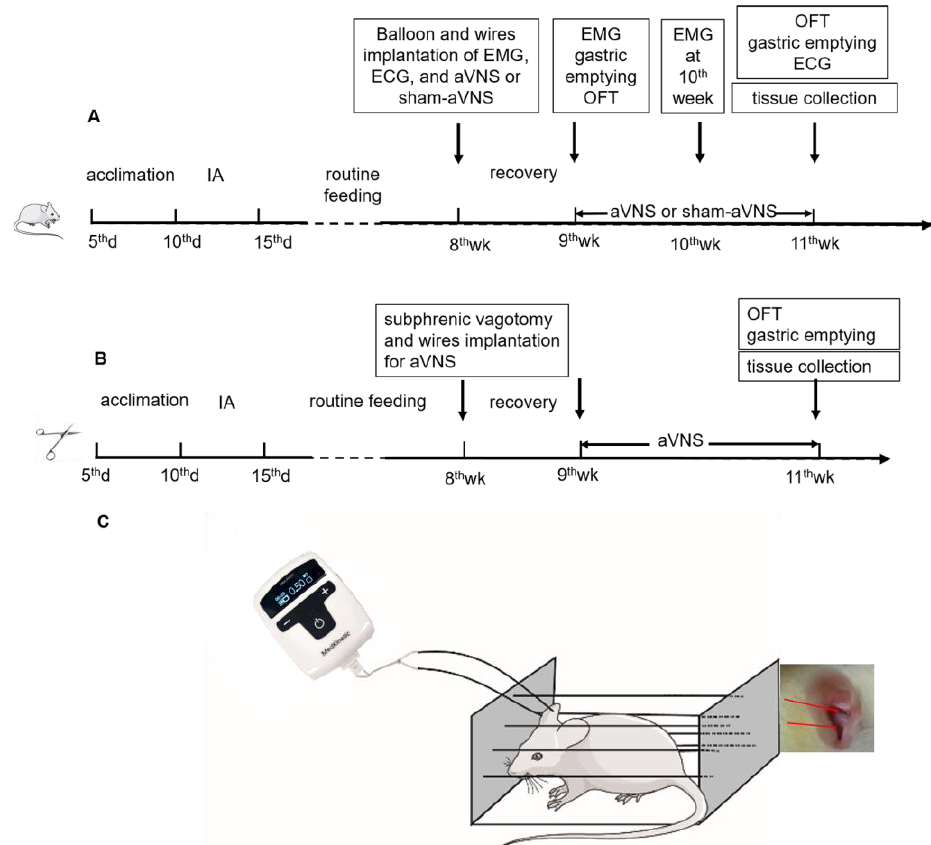
Figure 1. ( A ) Flowchart of experiment one. All ten-day-old SD rats except for control rats received iodoacetamide (IA) daily for 6 days and housed normally to grow until adulthood of 8 weeks old. Surgical implantations for ECG and EMG were performed at the age of 8 weeks and then recovered for 1 week. Physiological measurements were made at the 9th week and after the 11th week. Wire implantation for aVNS or sham-aVNS were performed at the age of 8 weeks and then recovered for 1 week at each group. The treatment (aVNS or sham-aVNS) was conducted for 2 weeks (9th week to 11th week). Only the EMG was performed after the 9th week and 10th week. ( B ) Flowchart of experiment two. All ten-day-old SD rats received the same IA treatment. Subphrenic vagotomy were performed at the age of 8 weeks and then recovered for 1 week. aVNS was conducted as experiment one. Physiological measurements were made after the 11th week. ( C ) aVNS schematic diagram.